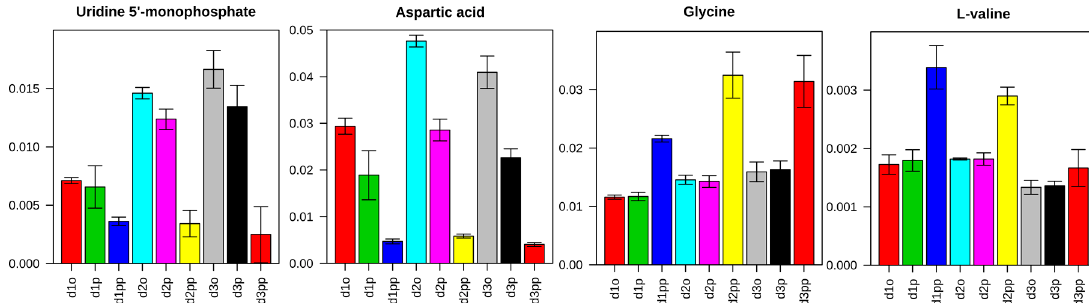
Figure 3. Example of regulated metabolites in control and two treatment groups at three time points. Uridine 5´-monophosphate (UMP) and aspartic acid showed correlated down regulation with treatment concentrations while glycine and valine showed significant up regulation only in the 50 µM XD treatment groups.